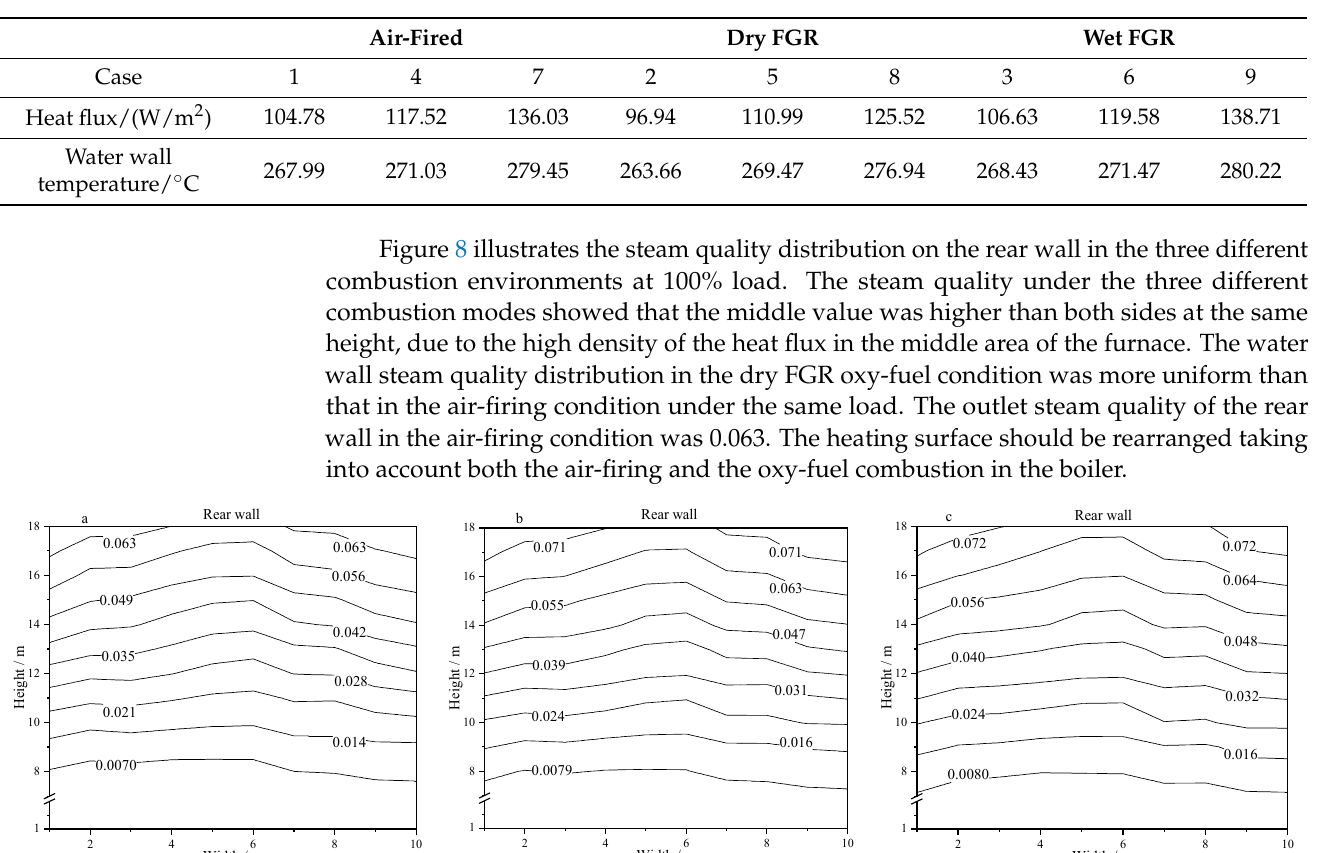
Figure 8. Distributions of the steam quality on the rear wall. ( a )-case 7, ( b )-case 8, and ( c )-case 9.